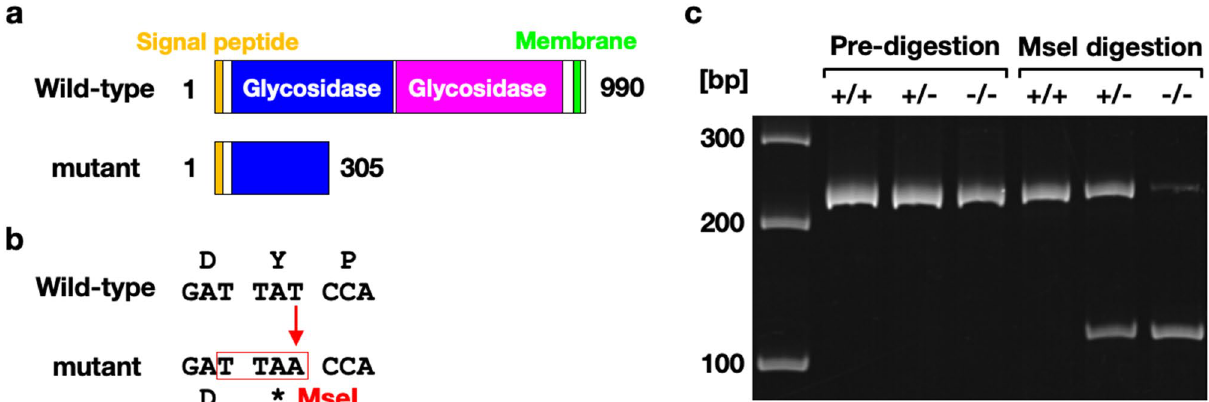
Figure 1. A nonsense mutation of zebrafish kl gene . ( a ) The αklotho protein has a signal peptide, two glycosidase domains and a transmembrane domain. A nonsense mutation caused a truncation in the first glycosidase domain. ( b ) The T-to-A mutation generated an MseI restriction enzyme site. ( c ) The size of the genomic PCR products was 240 bp. The PCR products amplified from mutant alleles were digested by MseI to generate two 120-bp